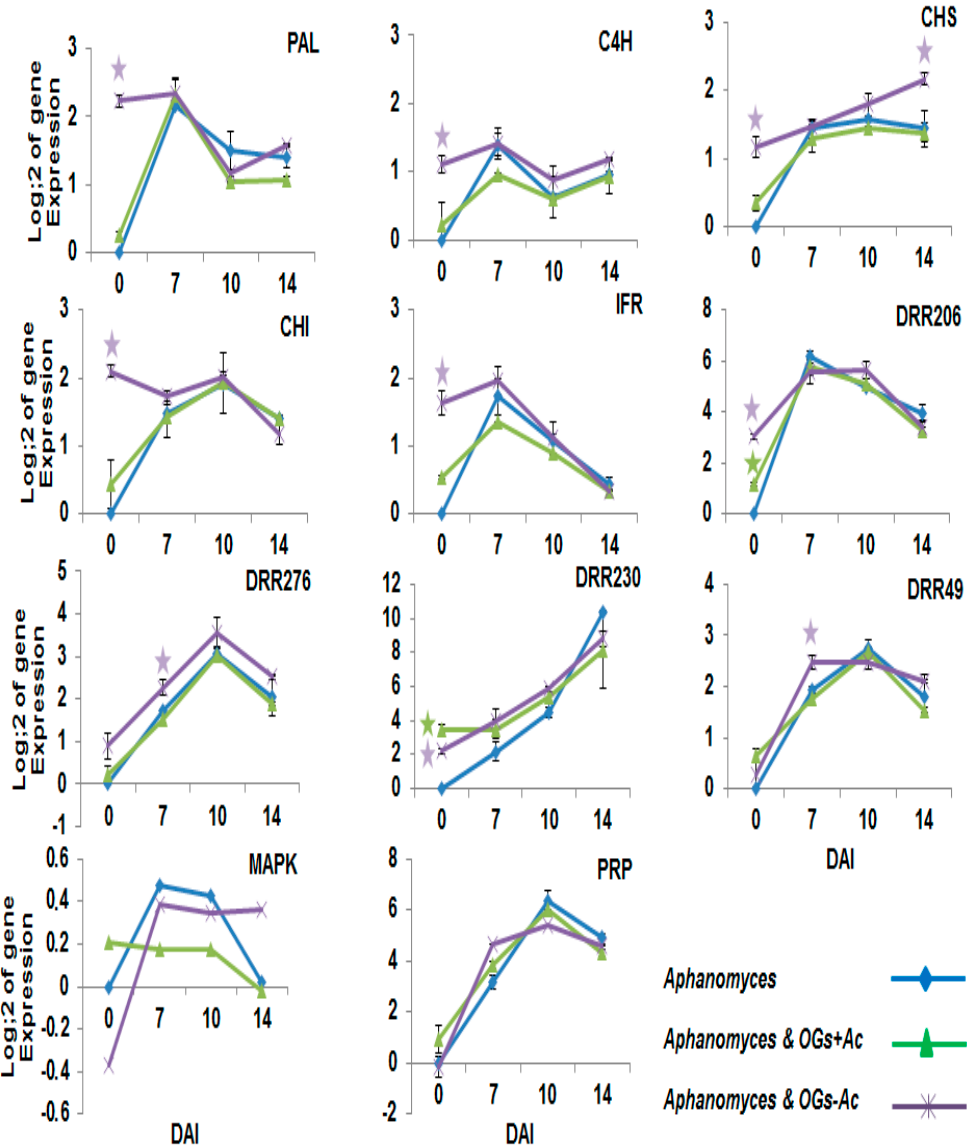
Figure 6. PAL gene expression ratio at 3, 6, 12, 24, 48, 96, 168 and 336 hours after treatment (hat) with water, 80 µg/plant of acetylated oligogalacturonides (OGs + Ac) or 200 µg/plant of nonacetylated OGs (OGs − Ac). The elicitor injections were done two weeks before inoculation (wbi) and two and one wbi for OGs − Ac and OGs + Ac, respectively. After inoculation with 10 5 Aphanomyces euteiches zoospores/plant, PAL gene expression was followed over the same time course (hours after inoculation (hai)). The values shown are means of five repetitions. ☆ Stars indicate gene induction ≥ 2-folds and significant differences between elicitor treatments and inoculated non-treated control according to the Tukey test ( p ≤ 0.05).